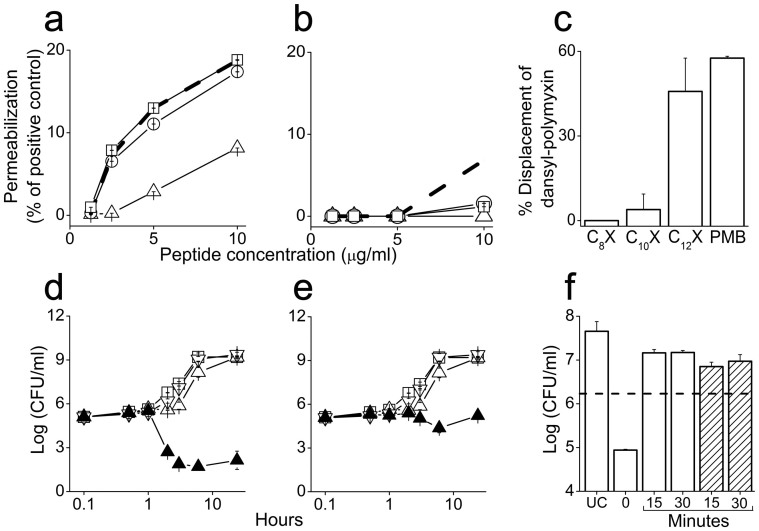
Mechanistic studies.(a,b) Dose-dependent permeabilization of outer and cytoplasmic membranes, respectively, using the E. coli mutant ML-35p. Symbols: triangles, C12(ω7)X; circles, C10X; dashed lines, C12X; squares, polymyxin B. Dermaseptin K4K20-S4 (57 μg/ml) was used for full permeabilization of both membranes. (c) Dansyl-polymyxin binding assay performed after pre-incubation (1.5 h at 10 μg/ml) of OAKs and polymyxin B with 2 μM pure monodansyl-polymyxin and 3 μg/ml LPS from E. coli. (d,e) Time-kill kinetics upon bacterial exposure to C12(ω7)X alone and in combinations with rifampin (d) and erythromycin (e). Symbols: open squares, untreated control; open triangles, C12(ω7)X (5 μg/ml); inverted open triangles, rifampin or erythromycin (0.004 or 0.03 μg/ml, respectively); solid triangles, C12(ω7)X + antibiotic. (f) Effect of delayed exposure to rifampin or OAK; Bacteria (K. pneumoniae CI 1287) were exposed to both C12(ω7)X (5 μg/ml) and rifampin (0.008 μg/ml) without delay (t = 0) and after delayed exposure to rifampin (white bars) or OAK (striped bars) by 15 or 30 min in LB culture medium. CFU counts were determined after additional 3 h incubation in the culture medium. UC; untreated control. Dashed line indicates the inoculum. Error bars = s.d.